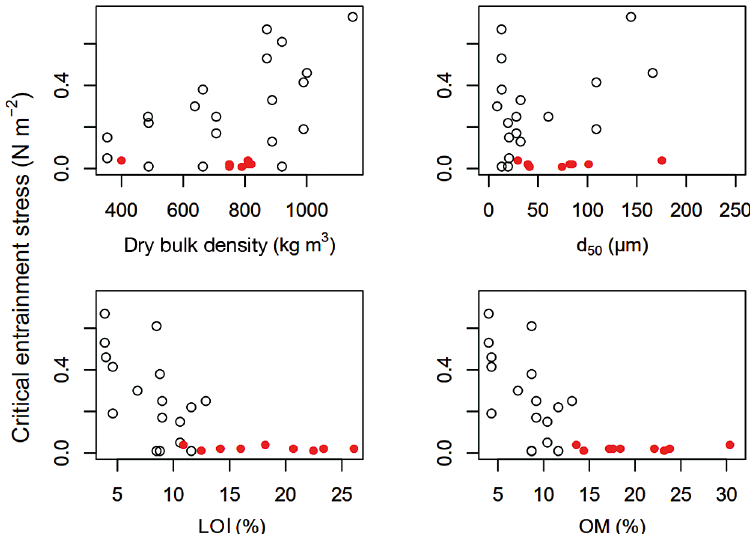
Fig. 7. Relationship between sediment characteristics and critical entrainment stress (open black discs: far-field survey, filled red discs: near-field survey). d 50 : median grain size; LOI: loss on ignition; OM: organic